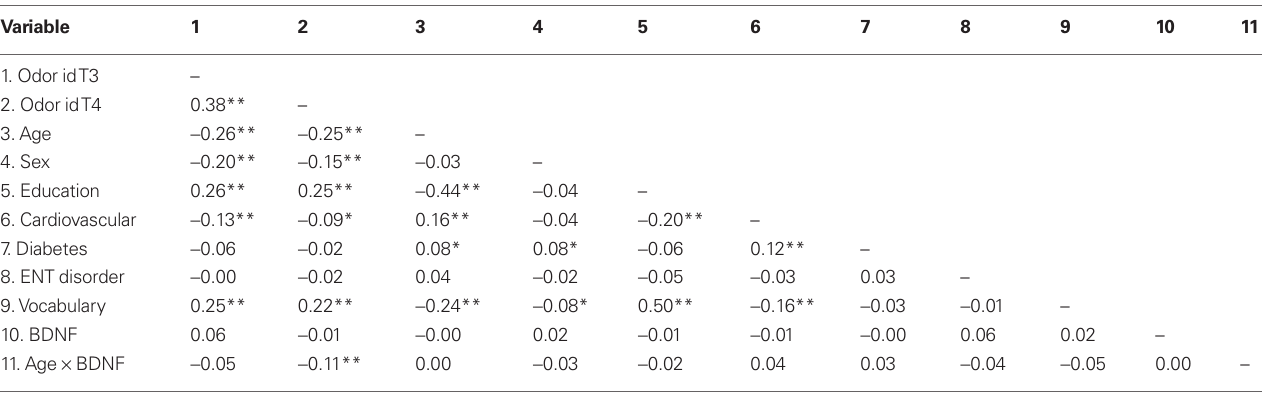
Table 2 | Intercorrelations among variables. Variable